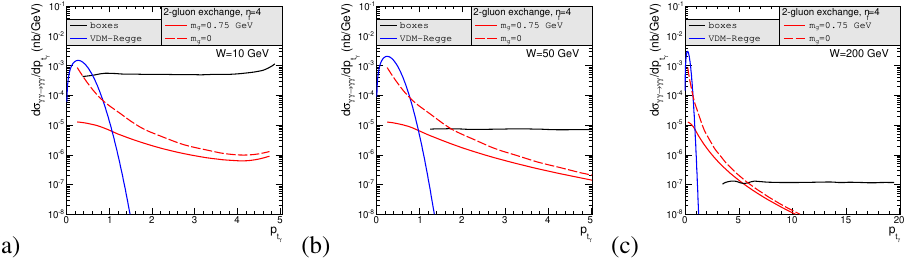
Figure 2. The di ff erential cross section as a function of transverse momentum of one of two outgoing photons for γγ → γγ scattering. Contribution of fermionic boxes (black lines), VDM-Regge (blue lines) and two-gluon exchange (red lines) are presented. Here energy W = (c) 200